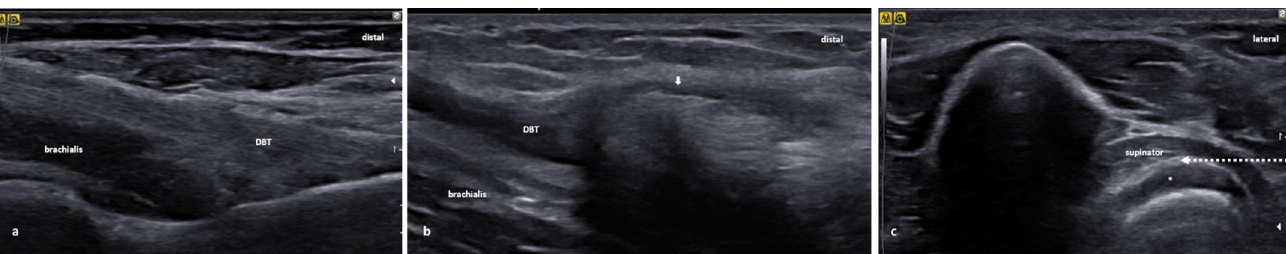
Figure 10. Ultrasound images of the DBT: ( a ) normal longitudinal image of the DBT; ( b ) DBT is torn and retracted, and the recoiled stump demonstrates the shadowing artifact (white arrow); ( c ) US-guided peritendinous injection of the DBT at its footprint (white asterisk) showing the needle (white, dotted arrow) being inserted from the “cobra position” of the patient’s forearm.